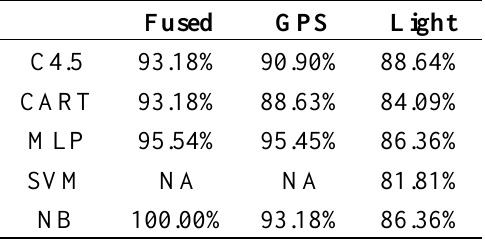
Table 8. Differentiating outdoors from